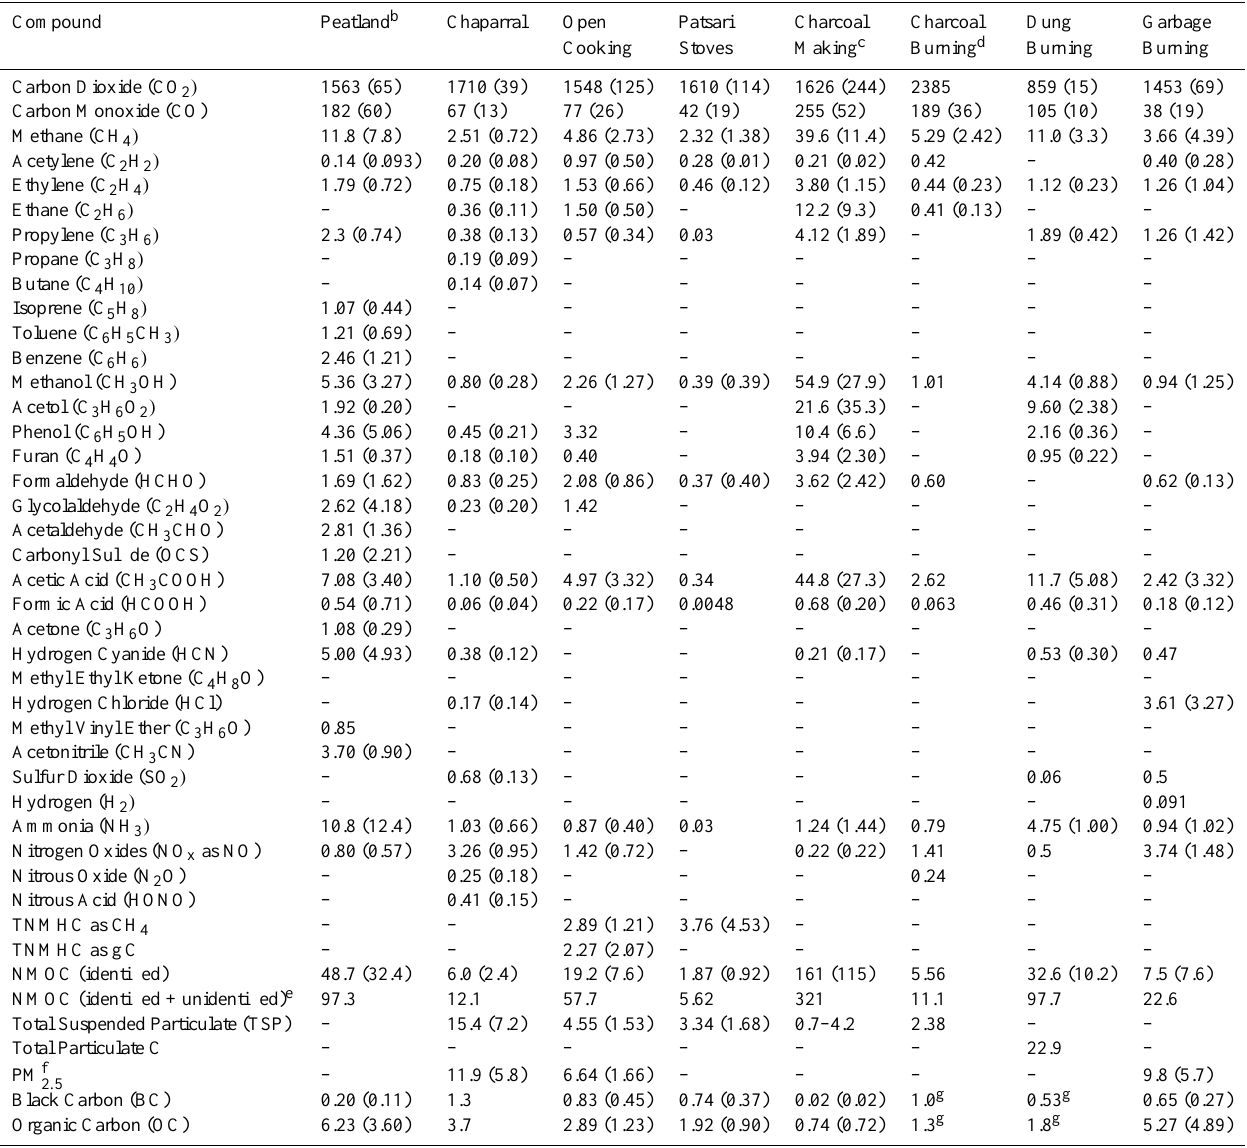
Table 2. Emission factors (gkg − 1 ) for species emitted from different types of biomass burning a . Compound Peatland b Chaparral Open Patsari Charcoal Charcoal Dung Garbage Cooking Stoves Making c Burning Burning Carbon Dioxide (CO 2